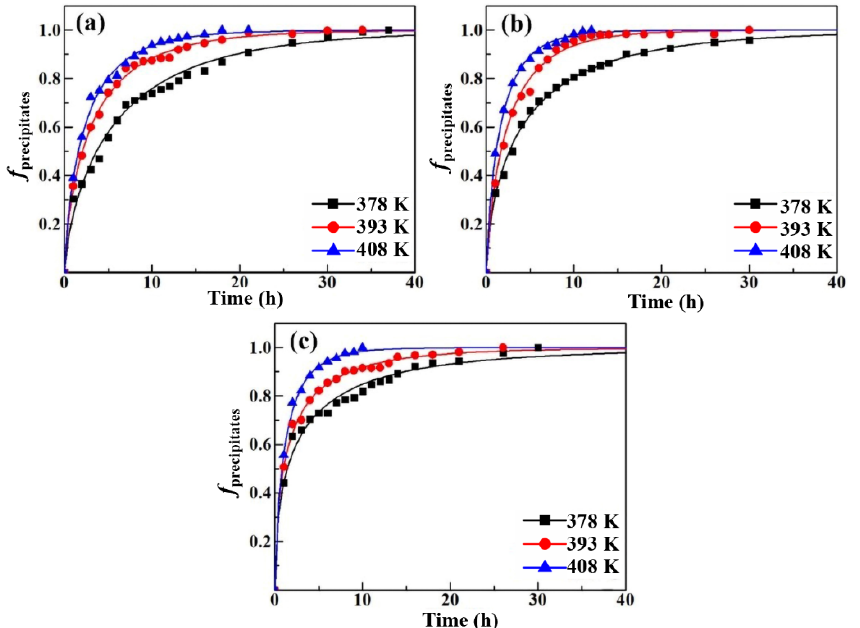
Figure 7. Relation between transformed fraction of the precipitates and aging time of Al-5Zn-2.6Mg- xCu alloys at different temperatures: ( a ) x = 0.24 wt.%, ( b ) x = 0.43 wt.%, and ( c ) x = 0.91 wt.%. Table 4. Precipitation kinetics equations of different Al-5Zn-2.6Mg-xCu alloys and temperatures of aging treatment.